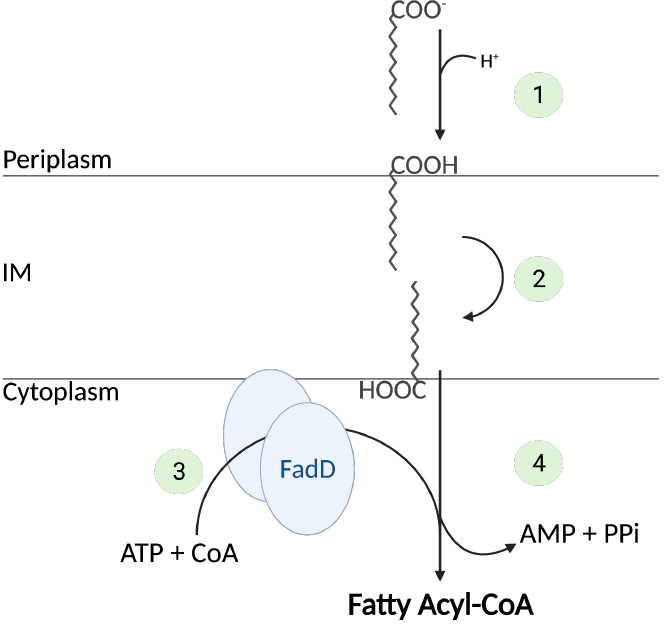
Figure 3. Vectorial transport and activation of FAs by FadD. Free FAs are protonated in the periplasm and then partitioned into the inner membrane (1). After flipping to the cytoplasmic face of the inner membrane (2), the free FAs recruit FadD proteins to the membrane (3), which extract them from the membrane concomitantly with their activation to acyl-CoA (4). Numbers correspond to the four steps required for the translocation and activation of the FA. IM = inner membrane, ATP = adenosine triphosphates; CoA = coenzyme A; AMP = adenosine monophosphates; PPi = pyrophosphate. Modified from [14].